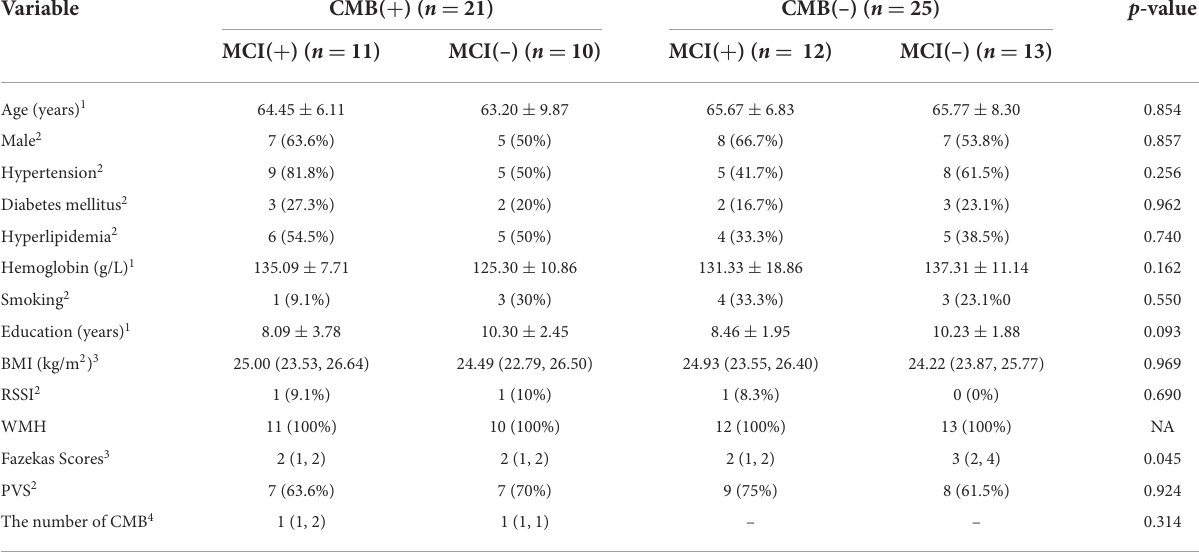
TABLE 2 The characteristics of participants with or without